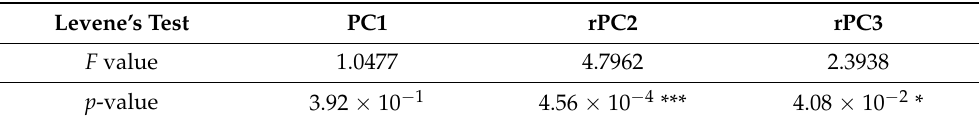
Table 3. Levene’s test for homoscedasticity against N fertilization. rPC2 and rPC3 are ranked (Gaus- sian) transformations of PC2 and PC3. Degrees of Freedom are 135 for all 3 variables. Significance codes: p -value < 0.001 ***, p -value < 0.05 *.